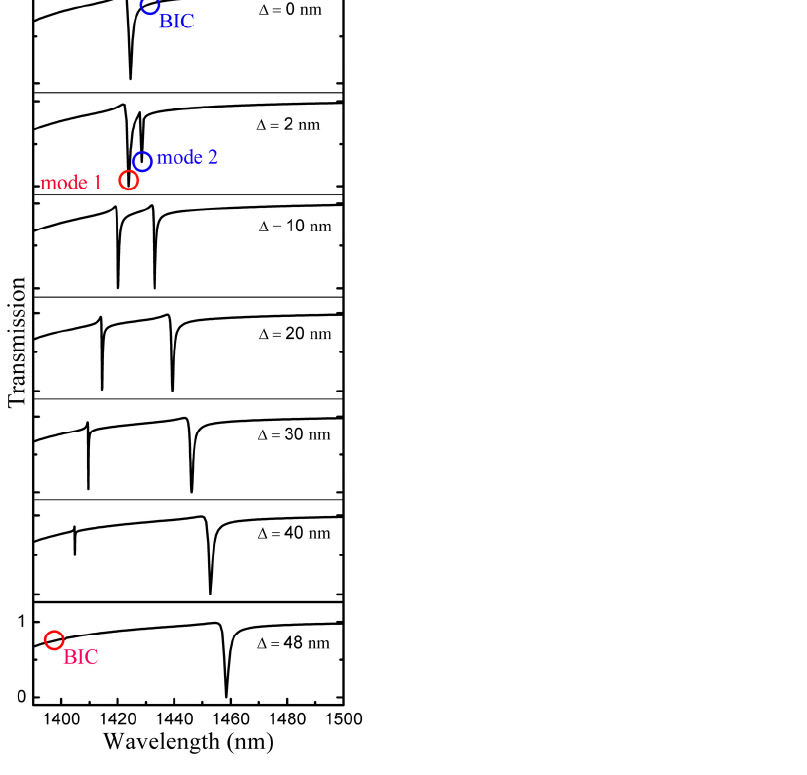
Figure 6. The calculated transmittance spectra when Δ changes from 0 nm to 48 nm. Two resonance responses are marked by mode 1 and 2, respectively. We analyzed the effect of structural parameter changes on the transmission spectrum when Δ = 10 nm, as shown in Figure 7. It is clear that the resonance wavelength is more sensitive to the height and side length of the Si plate and the square nanohole than it is to the period. With the period P increasing, there is a little redshift in the resonance trans ‐ mission spectrum of the metasurface. As the Si plate’s height H and side lengths W 1 and L grow, the resonance becomes noticeably red ‐ shifted. However, the resonance exhibits a distinct blue shift as the square nanohole’s side length rises. It can be explained by the effective refractive index of the metasurface. As the side length of the nanohole increases, the effective refractive index of the metasurface declines, and the interaction between light and matter in the resonant cavity gradually reduces, resulting in a blue shift of the reso ‐ nance position. As the period, side length of the Si plate increase, the surface area of the metasurface, resulting in an increase in the effective refractive index, and the interaction between light and matter in the resonant cavity gradually increases, resulting in a red shift of the resonance position [45]. The resonant line width and Q ‐ factor, however, are little affected by an increase in period H and side length W 1 . Additionally, with an increase in side length L from 780 nm